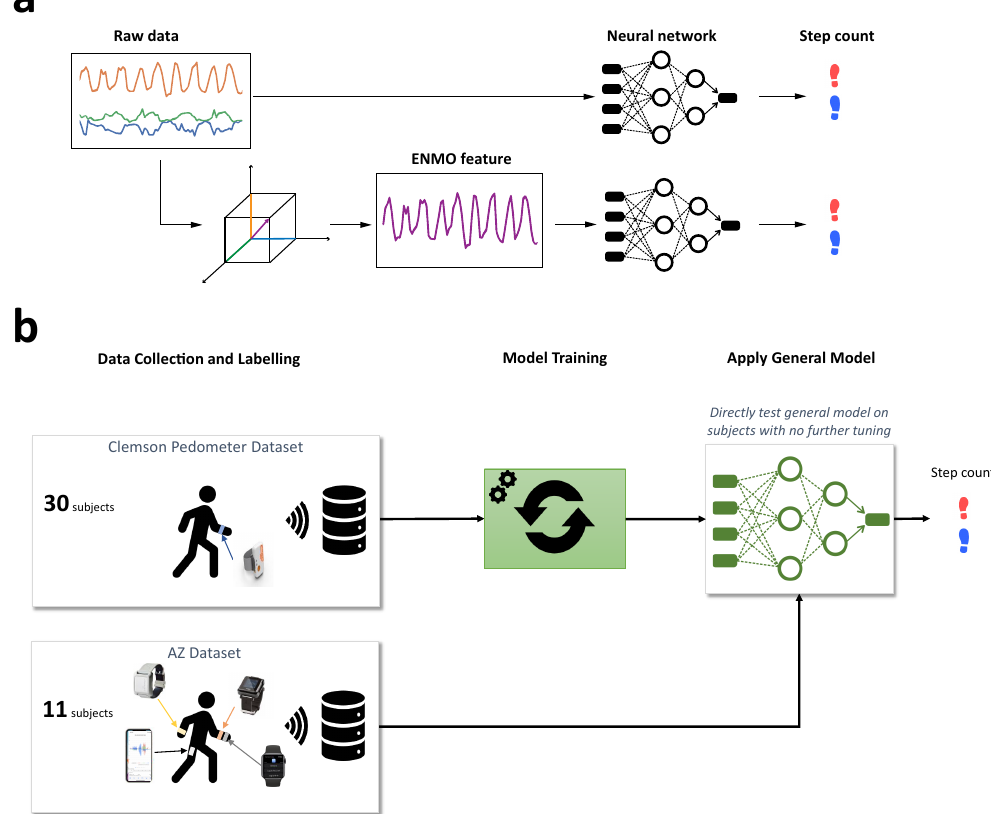
Figure 4. Workflow of training and testing step-count algorithms. ( a ) Model input was either the raw acceleration signal or the ENMO feature; ( b ) Generalized transfer learning on test